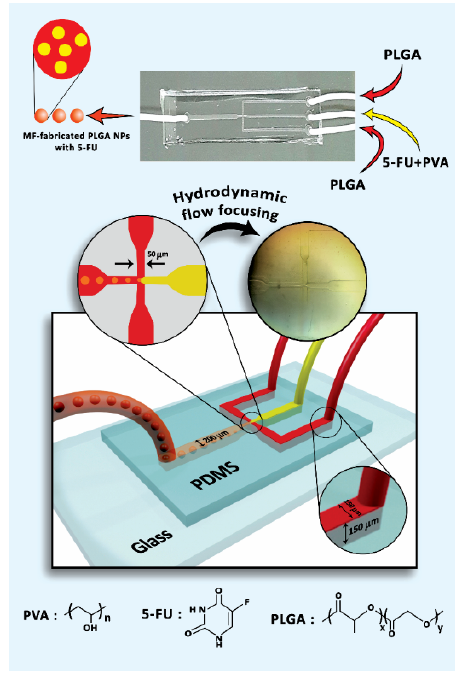
Figure 1. Schematic of microfluidic (MF) device setup.